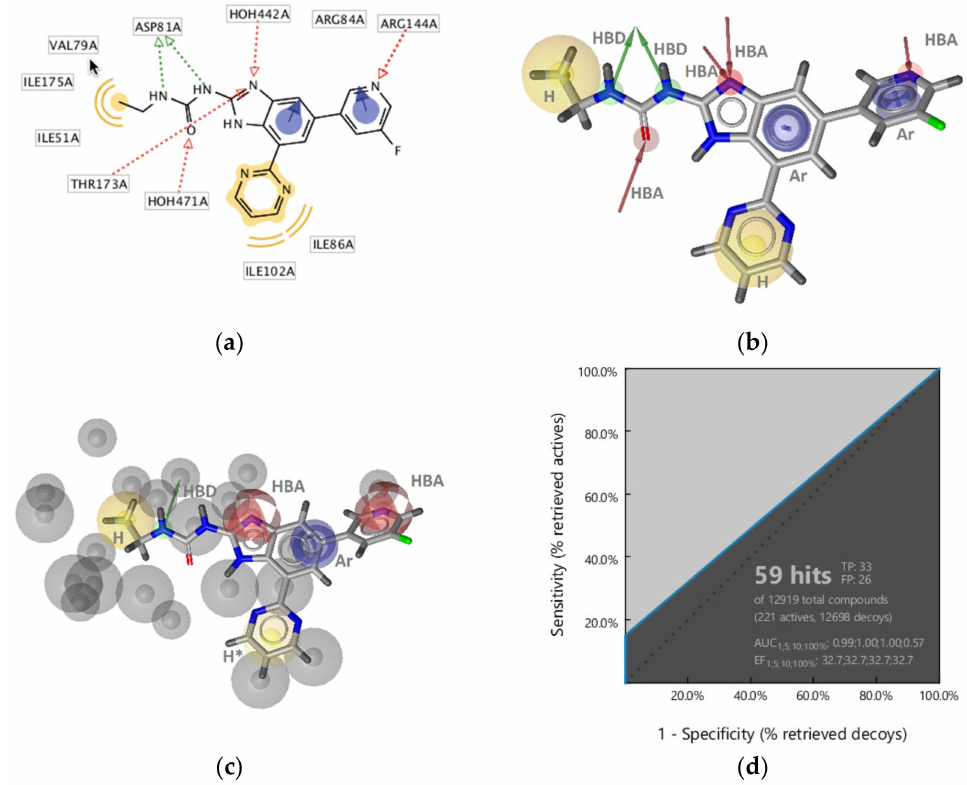
Figure 4. 3D-Structure-based interactions derived from the X-ray structure of GyrB and an ethylurea inhibitor (PDB ID: 4P8O): ( a ) 2D-depiction with binding site interaction partners and ( b ) 3D-depiction of initial SB-pharmacophore model with the ligand; ( c ) The refined SB-Gyr-Model-2 , ( d ) ROC plot (curve shown in blue) from virtually screening 12,919 compounds (221 GyrB actives and 12,698 gen- erated decoys) with SB-GyrB-Model-2 . TP = true positives; FP = false positives; AUC = area under the curve; EF = enrichment factor. Displayed pharmacophore features are: hydrophobic (H, yellow spheres), aromatic (Ar, blue disc), hydrogen bond donor (HBD, green arrow), and hydrogen bond acceptor (HBA, red arrow and red sphere). Optional pharmacophore features are marked with